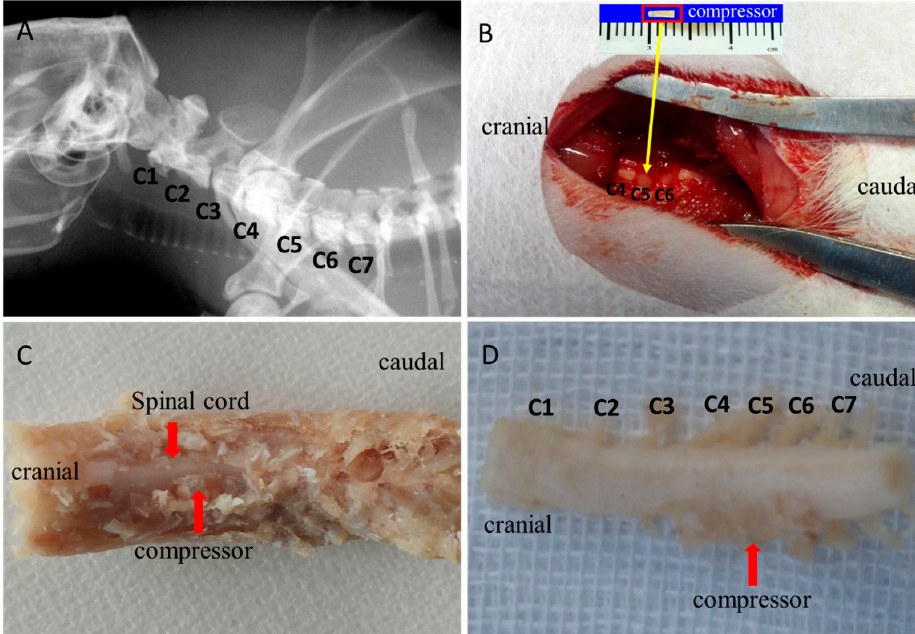
Figure 1. Establishment of experimental CSM model. ( A ) Preoperative spinal localization by X-ray fluoroscopy. ( B ) C4 lamina removing and polymer sheet implantation into C5 epidural space. ( C ) Ex vivo spinal specimen with compressor. ( D ) Expanded compressor identified at C5–C6 cord level.